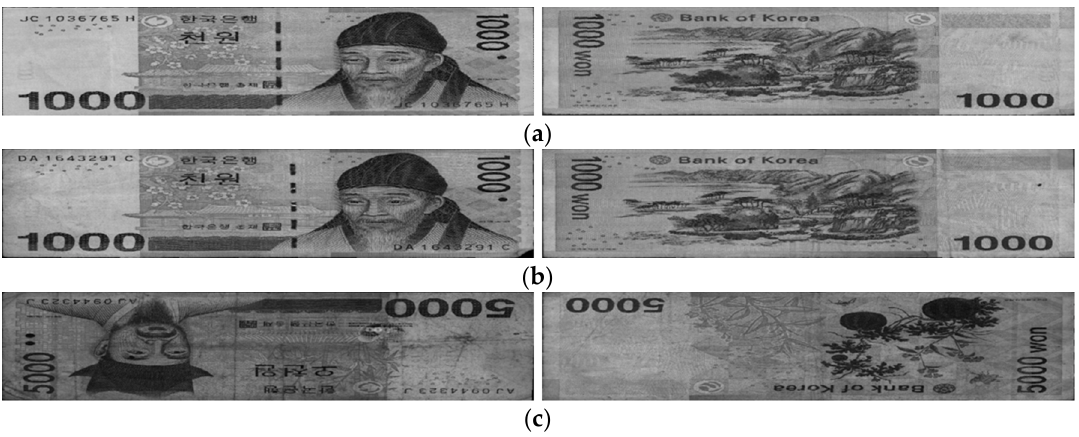
Figure 4. Example of banknote images in the KRW database with fitness levels of ( a ) Fit, ( b ) Normal, and ( c ) Unfit.